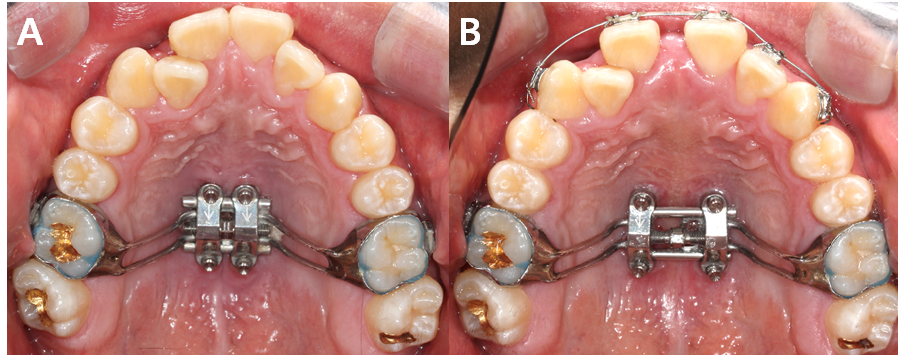
Figure 1. Maxillary skeletal expander. ( A ) Pre-expansion, ( B ) Post-expansion. 2.2. Standardized Reorientation of CBCT Images, 3D-Coordinate System, and 3D Measurement CBCT images were taken at T1, T2, and T3. A CBCT scanner, Alphard-3030 (Asahi All measurements were observed by an orthodontic resident (H.J.L.). CBCT images were re-oriented, and measurements were made using ON3D (3D ONS, INC., Seoul, South Korea) software. The 3D coordinates (x,y,z) were constructed using nasion (N) as the reference point (0,0,0). They were assigned according to the N point and the FH plane, which was defined as a plane passing through the bilateral orbitale (Or) points and the midpoint of the bilateral porion (Po) points (Figure 2) [21,22]. Three-dimensional landmarks were traced, and each landmark was assigned its 3D coordinates. The three-dimensional landmarks and values are described in Figures 3 and 4 and Tables 1 and 2.